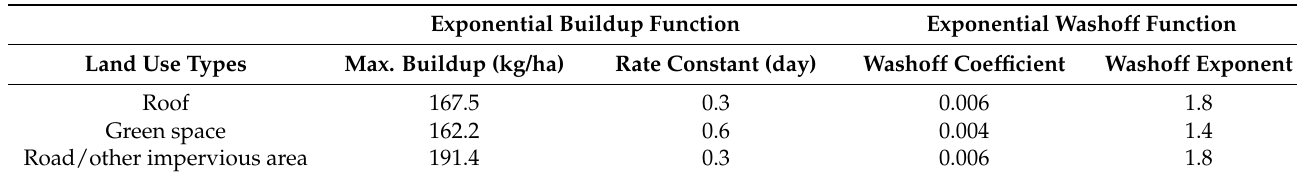
Table 4. Buildup and washoff parameters of the model.